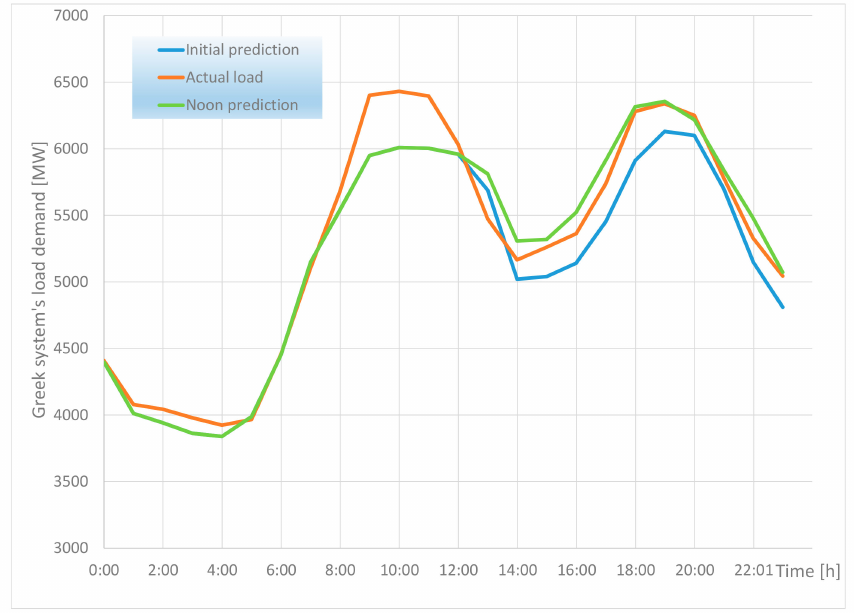
Figure 2. Initial day-ahead prediction, modified noon prediction, and actual load curve on a weekday in January 2023 [34]. The modified noon prediction reduces 24 h MAE from 177 to 131 MW, MAPE from 3.35% to 2.47%, and RMSE from 0.041 to